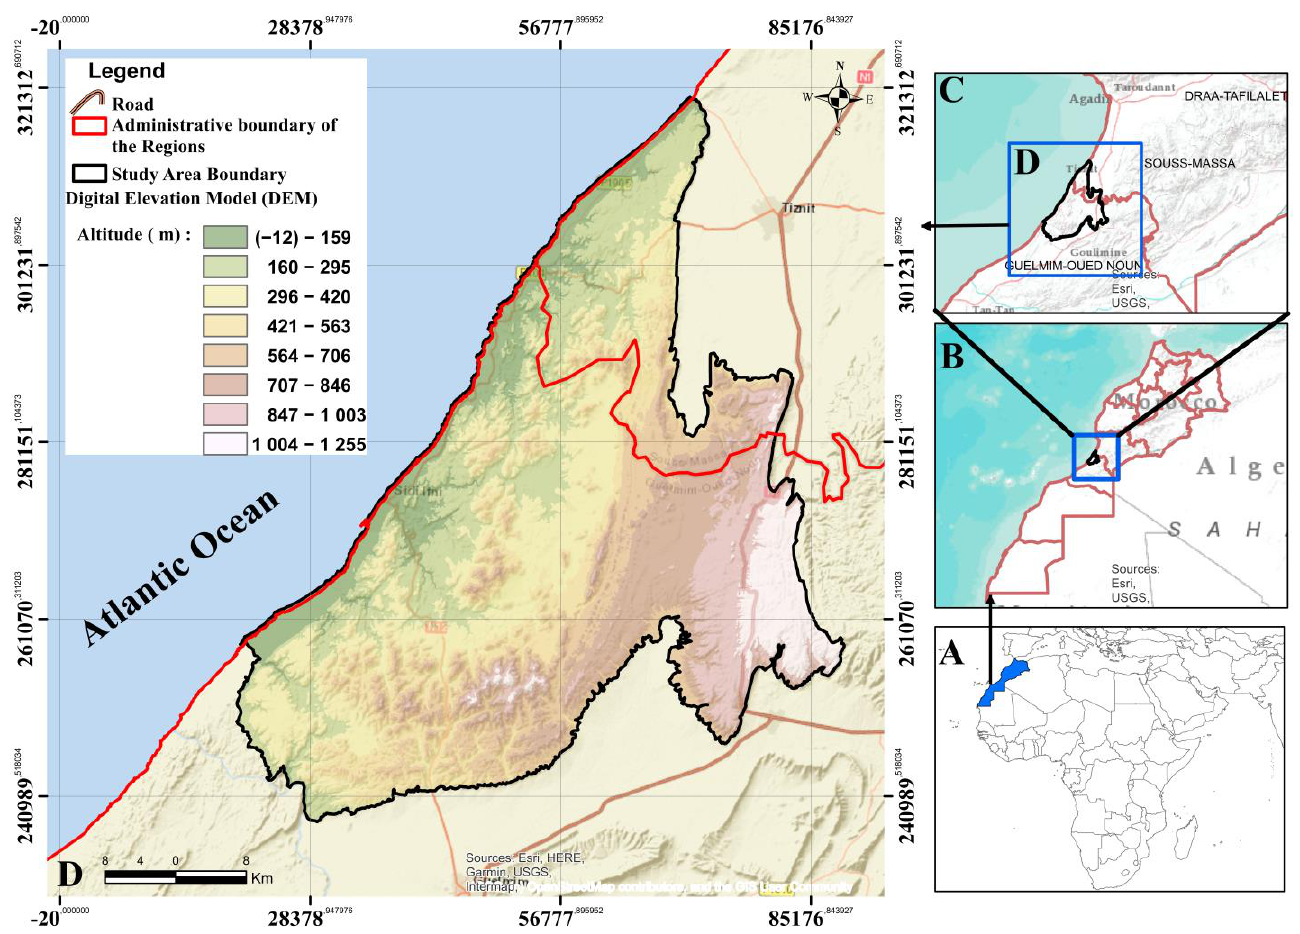
Figure 1. Geographical localisation of: ( A ) Morocco; ( B – D ) Ifni inlier and Lakhssas